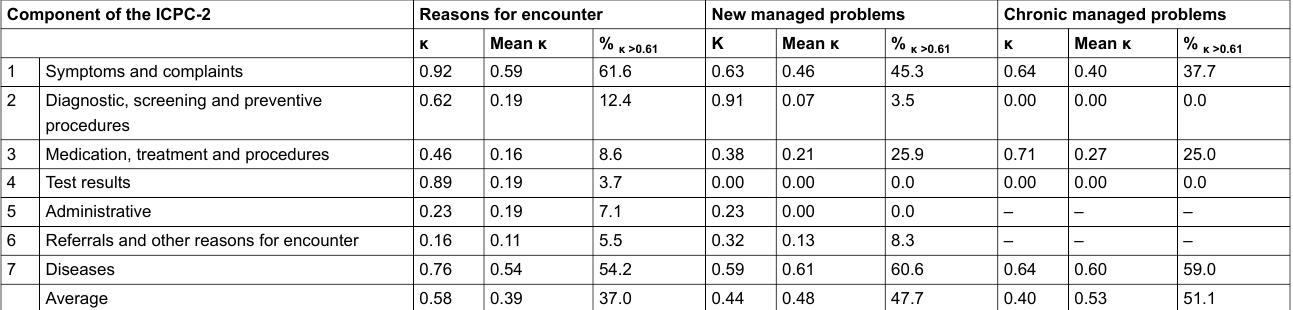
Table 3: Inter-rater reliability towards for reasons for encounter, new and chronic problems presented in Cohens Kappa on component level (κ), on single code level mean Kappa over all used codes (mean κ) and frequency of codes with good or very good Kappa (% κ >0.61 ). Component of the